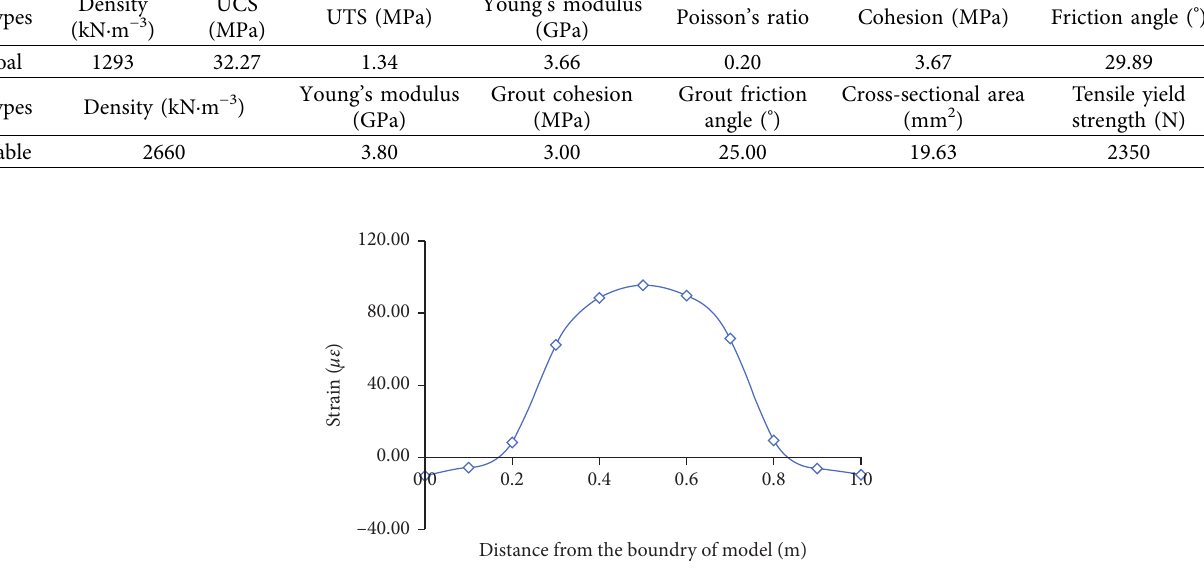
Figure 3: Numerical simulation of optical fibre strain curve.